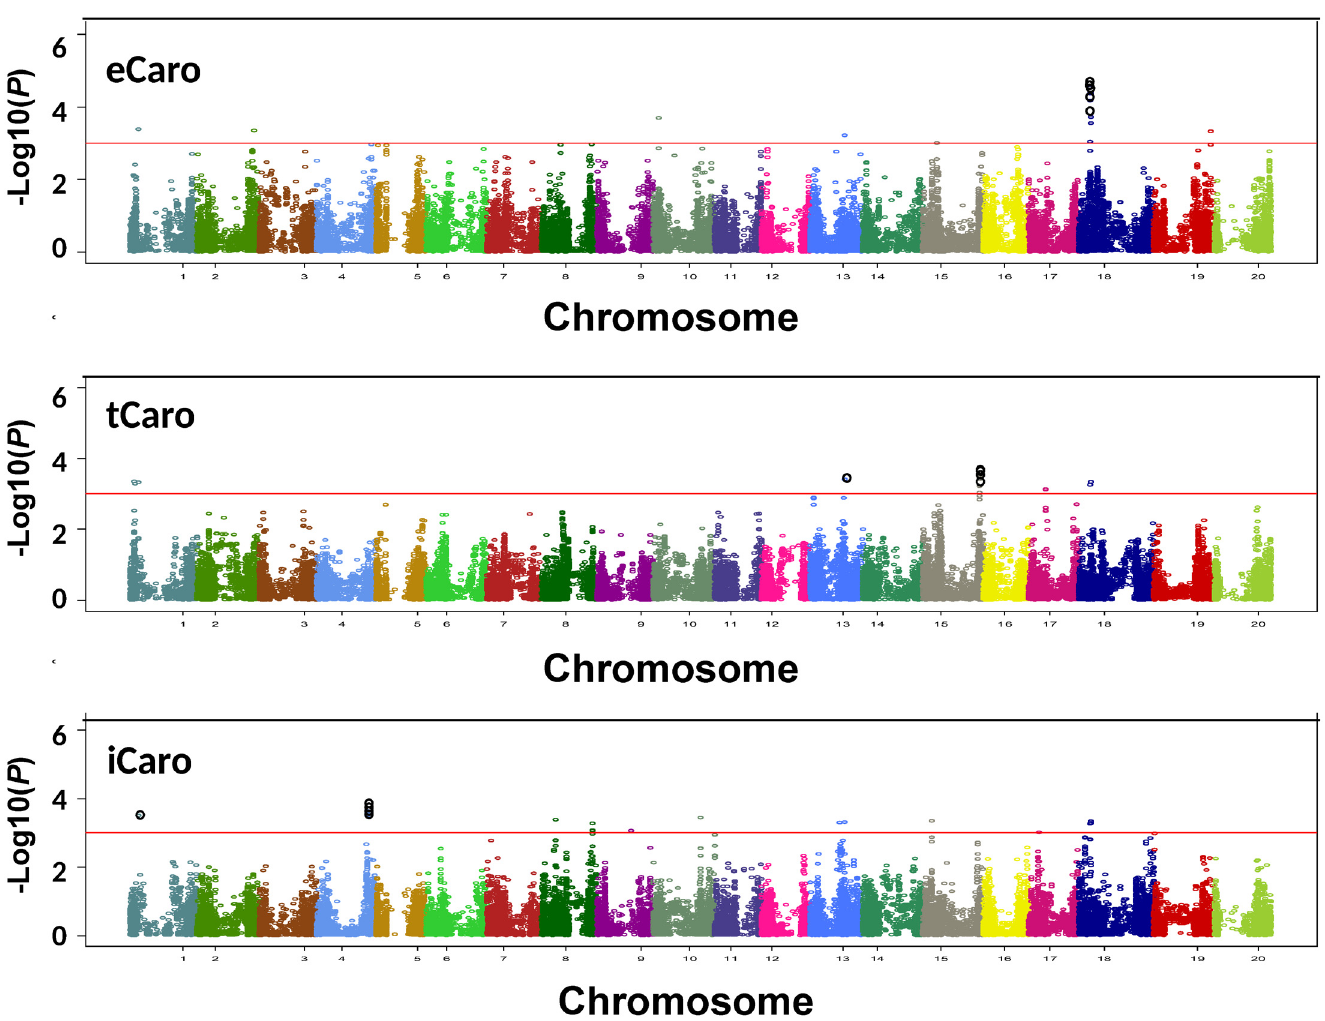
Fig 5. Manhattan plot of-Log10 ( P ) vs. chromosomal position of SNP markers for extractable carotenoid content (eCaro), wavelet transformed spectral reflectance carotenoid content (tCaro) and spectral index carotenoid content (iCaro) using MLM+Q+K model. The red line represents the threshold level of-Log 10 P (cid:5) 3.00. The five SNPs that showed the most significant association for each carotenoid phenotype are circled in